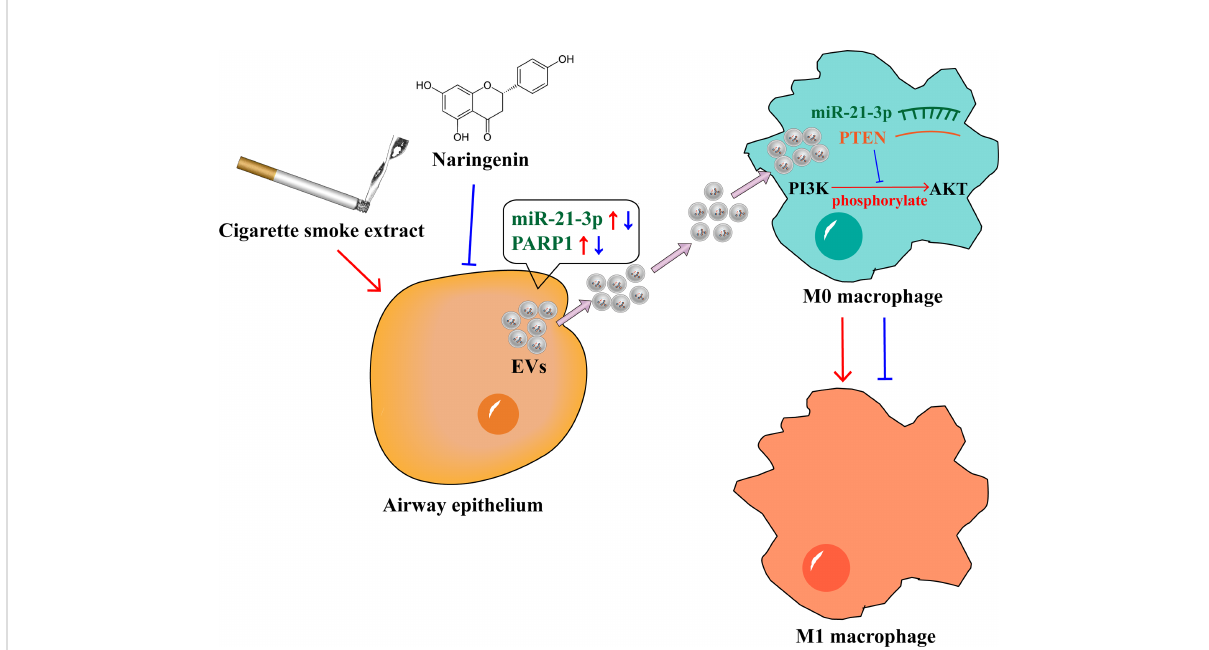
FIGURE 8 Naringenin suppressed BEAS-2B-derived extracellular vesicular cargoes disorder caused by cigarette smoke extract thereby inhibiting M1 macrophage